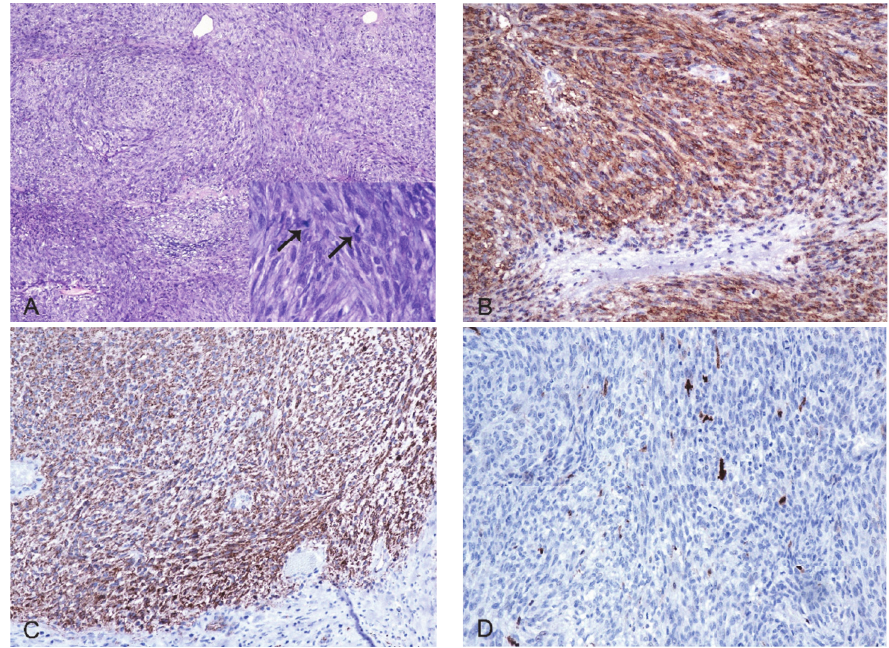
Figure 3: Cellular neoplasm, arranged in fascicles and whorls, with high mitotic rate (arrows indicate mitotic figures). (A) Hematoxylin-eosin stain. (B), (C), and (D) immunohistochemical staining for c-KIT, CD34, and S100, respectively. All images were captured under 200x original